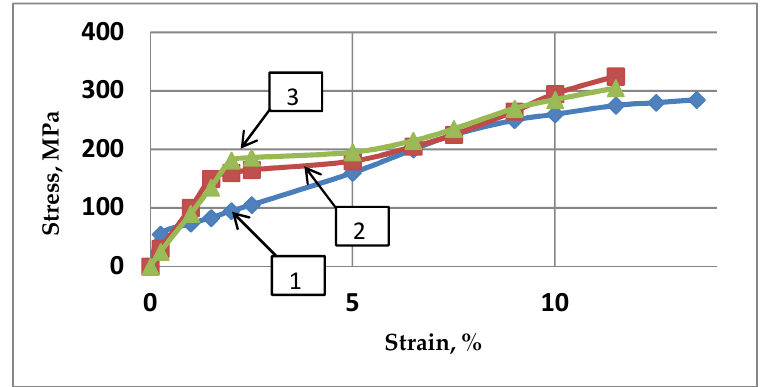
Figure 10. Dependence of the stress/strain response during ECAP compression of the AZ31 samples at RT: 1, as-cast ( ♦ ); 2, after 1st ECAP pass ( ■ ); 3, after 2nd ECAP pass ( ▲ ).